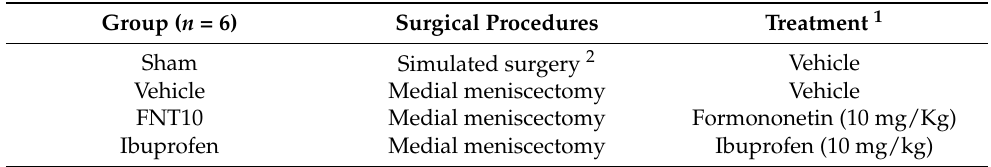
Table 1. Design of the experimental groups according to the surgical procedure used to induce osteoarthritis and treatment applied. Group ( n = 6) Surgical Procedures